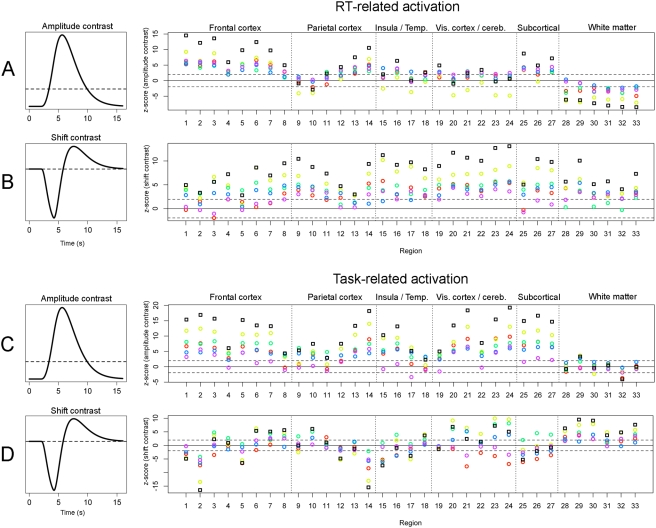
Statistical fit of RT-related and task-related activation to a priori linear contrasts.Top (panels A–B): RT-related activation. Bottom (C–D): task-related activation. Contrast weights for the amplitude contrast (panels A and C) and temporal shift contrast (panels B and D) are displayed on the left. The statistical significance (z-score) of the resulting test is displayed on the right for each of the 5 samples in each of the 33 ANOVA ROIs. Each color represents a different sample; black squares represent the fixed-effects z-score sum of all studies (see text). Region numbers correspond to IDs in Table 2 and Figures 3–
5. Dashed lines represent a p<.05 cut-off (|z| = 1.96).